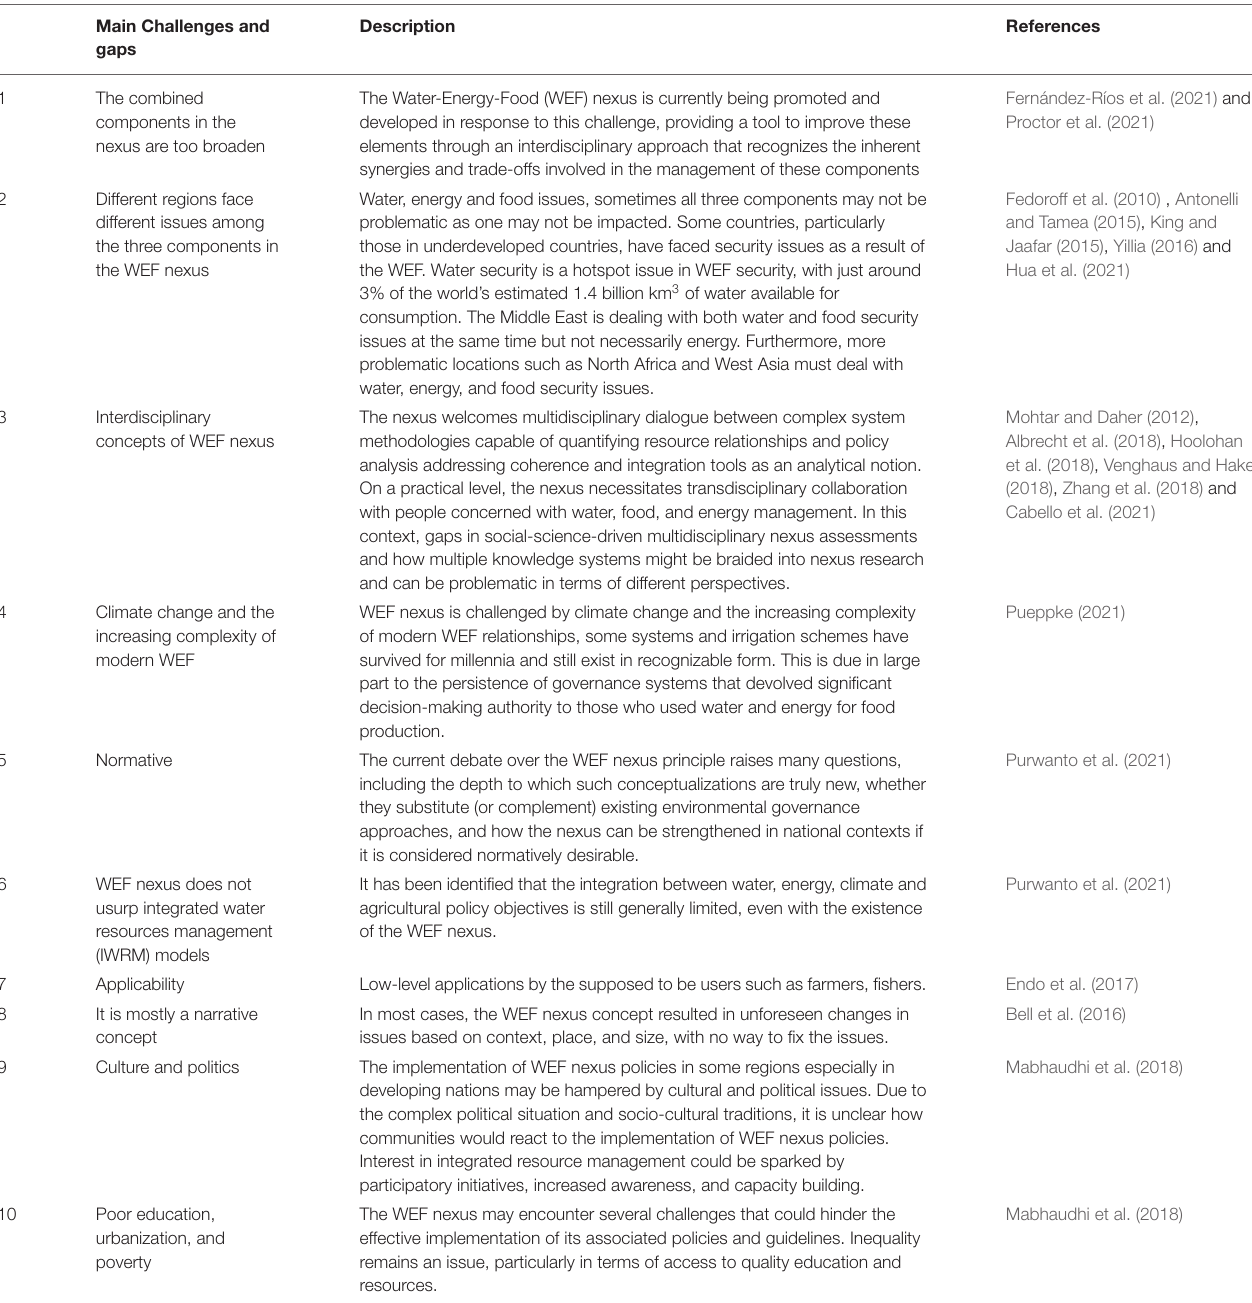
TABLE 2 | Challenges and gaps in the WEF